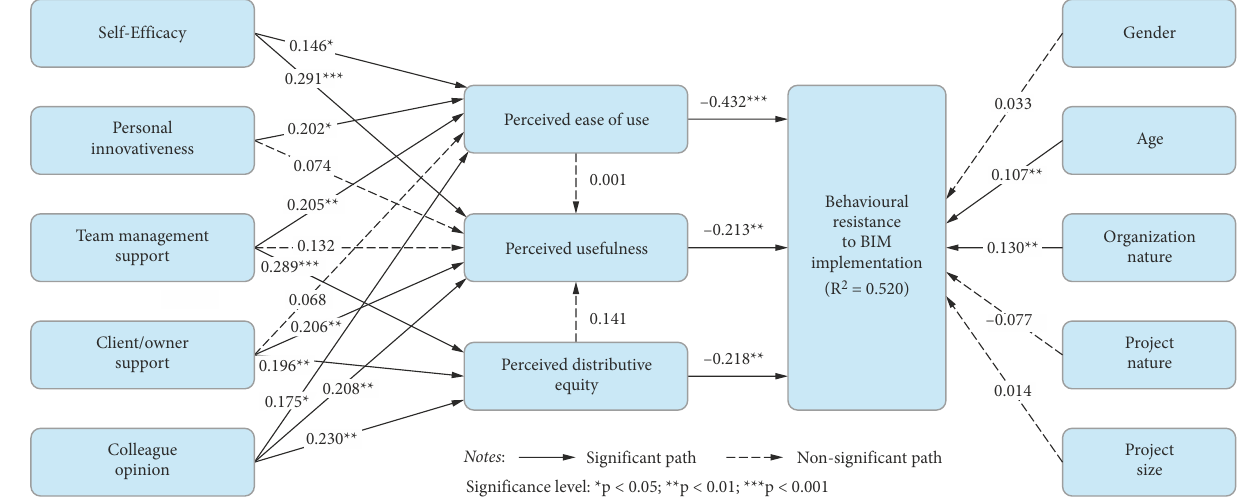
Figure 2. Results of PLS analyses for the research